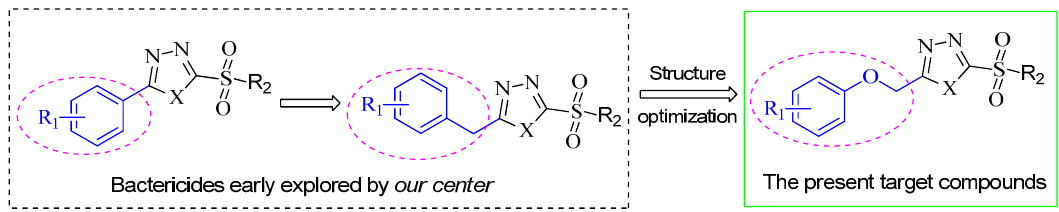
Figure 1. Strategic Design for the Target Compounds.